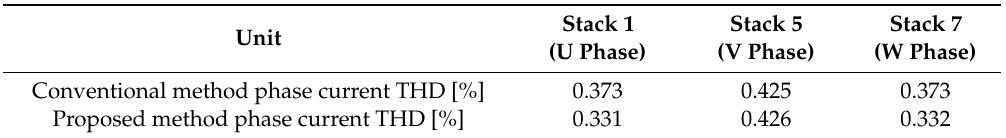
Table 4. Phase current THD comparison of conventional and proposed neutral-point voltage-shifting control when fourth stack